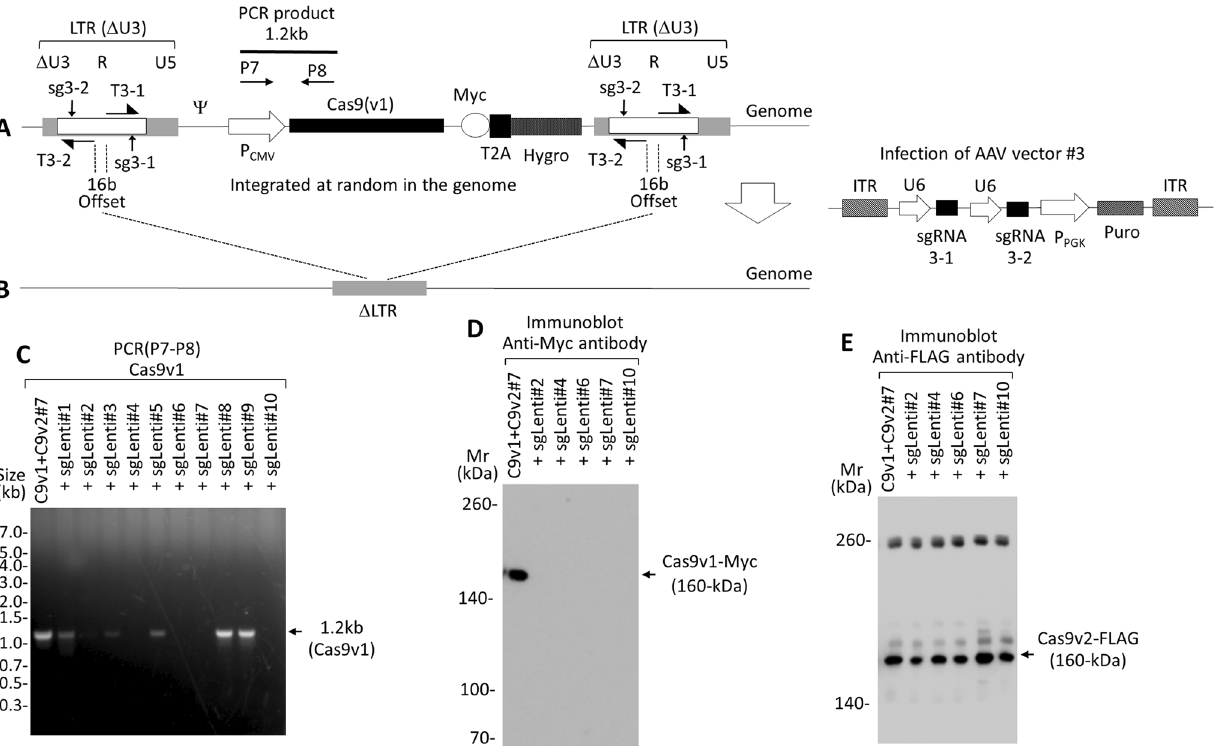
Figure 6. AAV vector #3 construct targeting the genome integrated lentivirus long terminal repeat (LTR). ( A , B ) AAV vector #3 targeting the LTR of the lentiviral vector (T3) was created by placing a pair of sgRNAs (sg3-1 and sg3-2) with 16 bp offset for DSB (double-strand break) by Cas9 nickase as well as wild-type Cas9 and placing a puromycin resistance gene between the ITRs. Primers P7–P8 for Cas9v1 are used to examine whether the lentivirus containing Cas9v1-Myc is removed by NHEJ with AAV vector #3 infection ( B ) The sgRNA and PCR primer sequences are shown in Supplementary Tables S1 and S3, respectively. ( C – E ) PCR analysis of genomic DNA prepared from the HEK293T-Cas9v1-Myc + full-length Cas9v2-FLAG #7 cells, and the HEK293T-Cas9v1-Myc + Cas9v2-FLAG cells (sgLenti #1–#10) expressing sgRNA3 targeting the lentivirus LTR, after AAV #3 vector infection and puromycin selection. The DNA was amplified using primers P7–P8 (for Cas9v1) ( C ). The lysates from the cells that had no 1.2 kb PCR products in ( C ) were analyzed by immunoblot